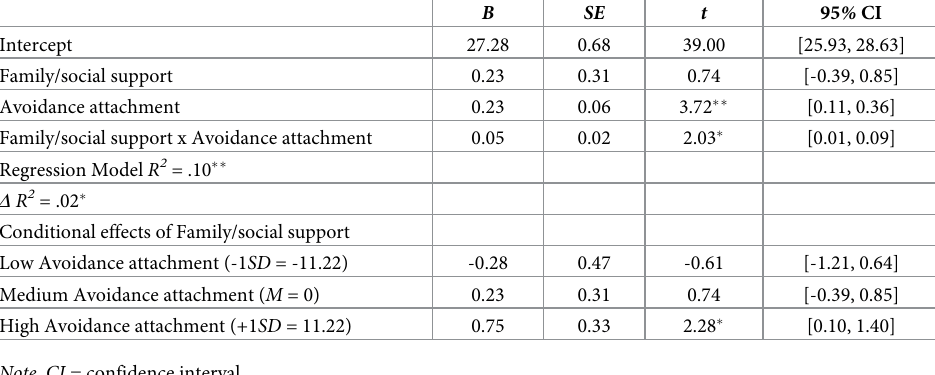
Table 4. Avoidance attachment moderates the relationship between family/social support and intensity of pro- longed grief symptoms.